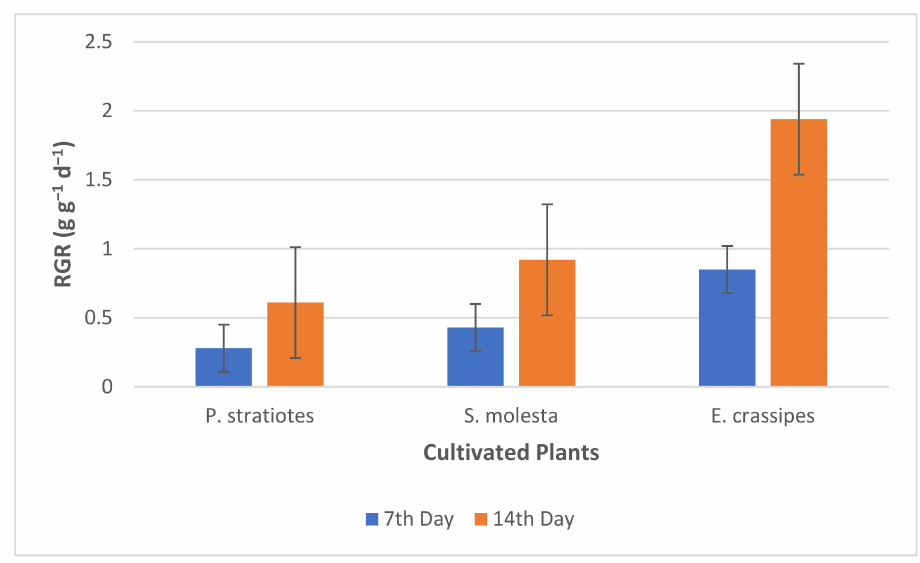
Figure 6. Graph of RGR (g g − 1 d − 1 ) against cultivated plants at 12 h retention